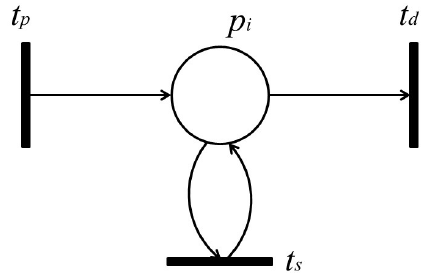
Figure 4. An enzyme place in a Petri net